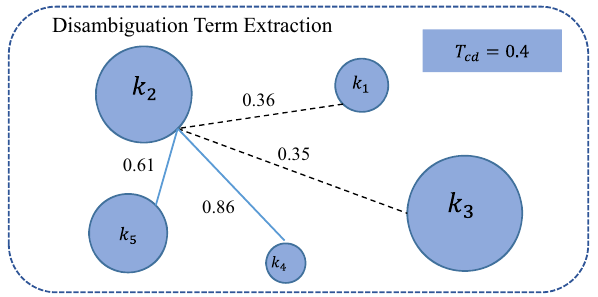
Fig. 4 An example of the disambiguation term extraction